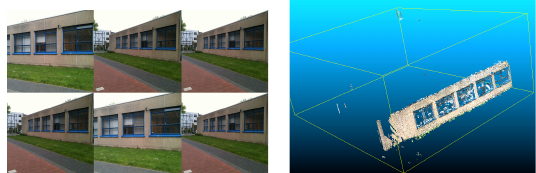
Figure 2: Left; some of the multi-view images of the building of interest. Right; point cloud generated from multi-view iPhone